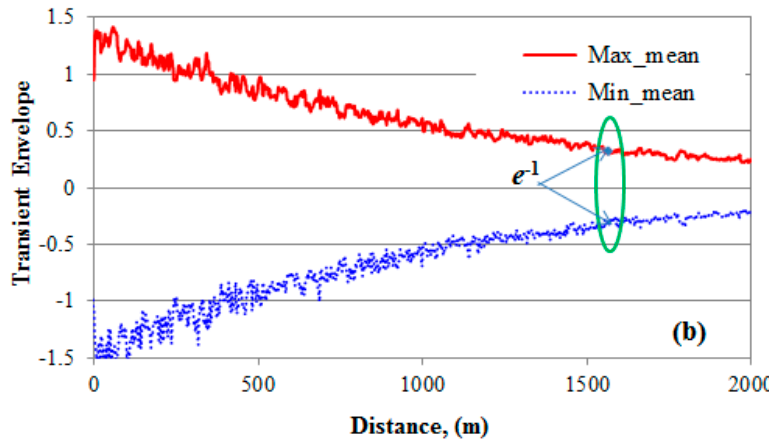
Figure 13. Results of the random disorder case with λ w /2 λ b < 1: ( a ) uniform distribution and α = 0.05 m − 1 ; ( b ) triangular distribution and α = 0.05 m − 1 .